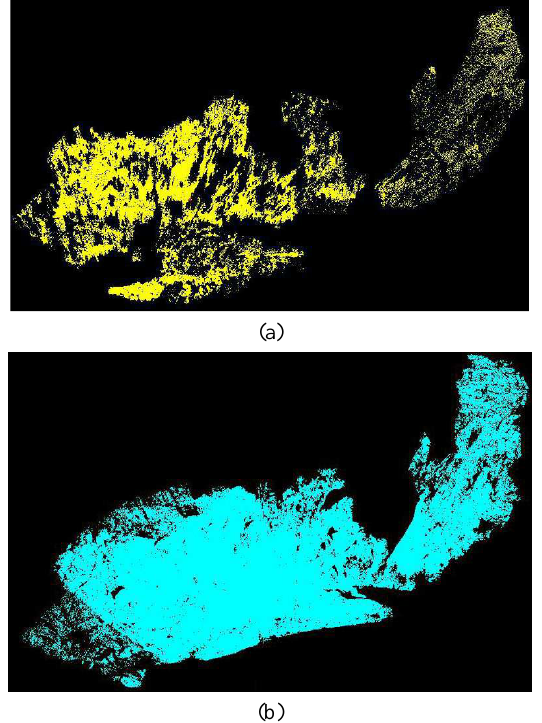
Figure 7: Point clouds resulting after the removal of the vegetation through the morphological filter. LMS- Z620 dataset (a), VZ-400 dataset